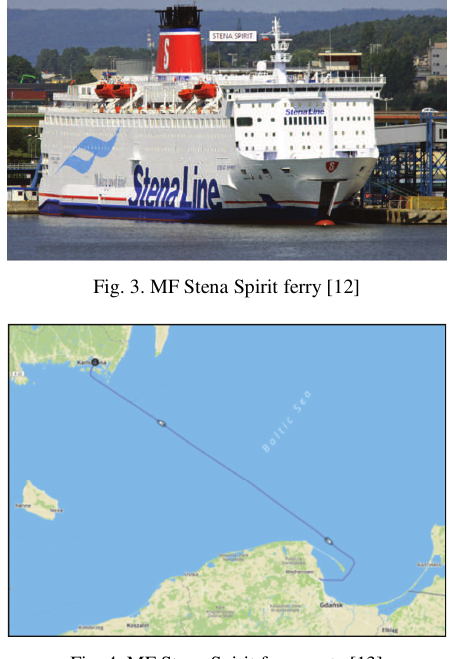
Fig. 4. MF Stena Spirit ferry route